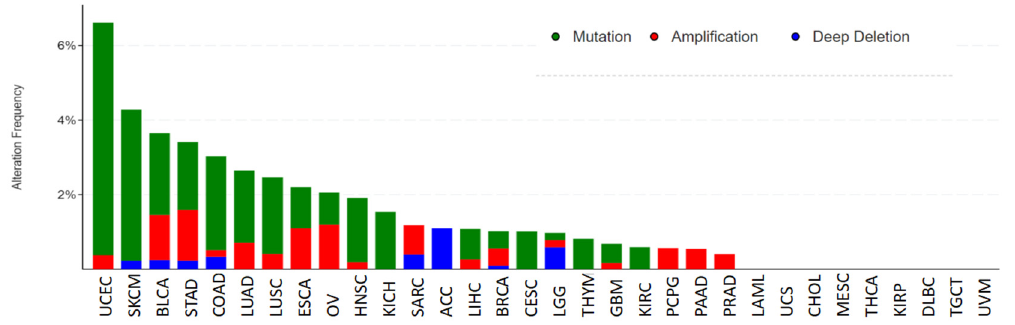
Figure 6. Genetic alterations of KIF18A in pan-cancer using the cBioPortal.